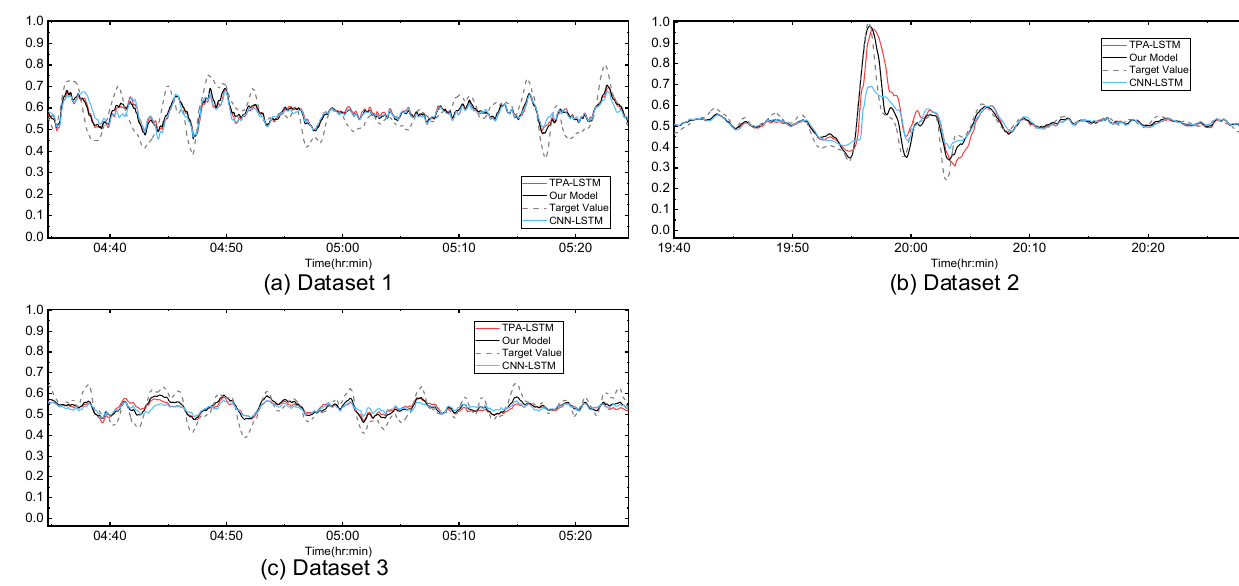
Experimental Group Control Group Target Value (c) Dataset 3 Figure 14. The prediction comparison diagram of segmented training.